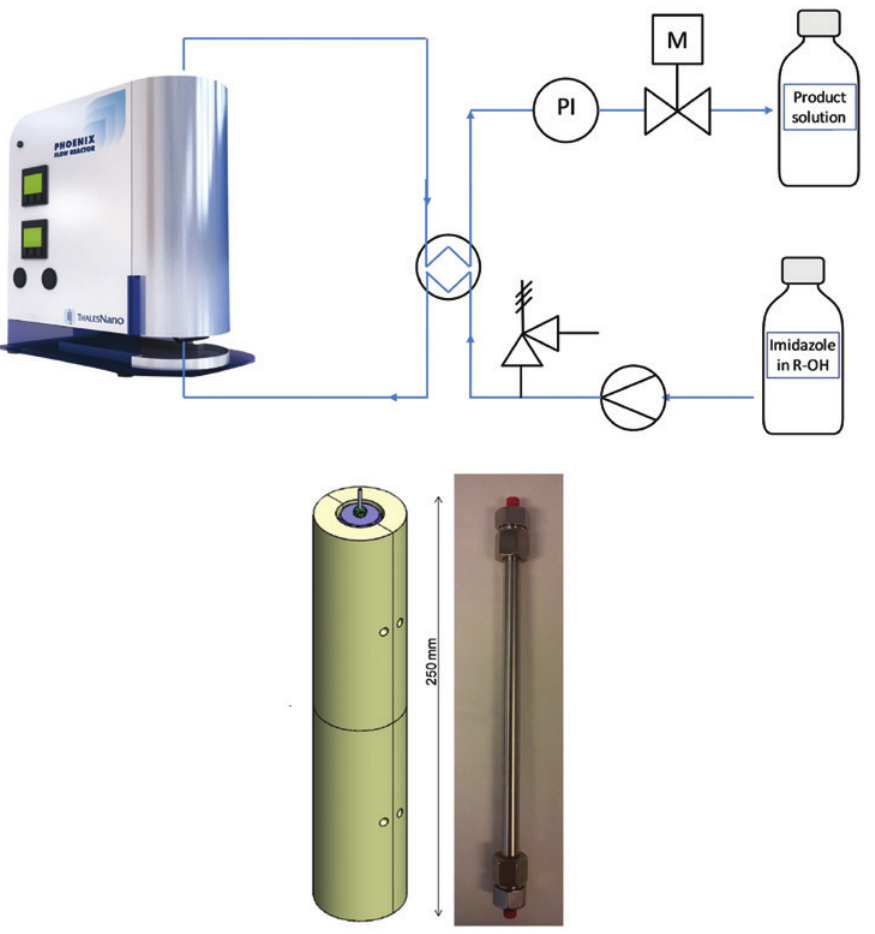
Figure 1: Experimental set-up for the continuous flow N -alkylation of imidazole. Below: reactor tube (right) and reactor tube within the heating element of the reactor (left).